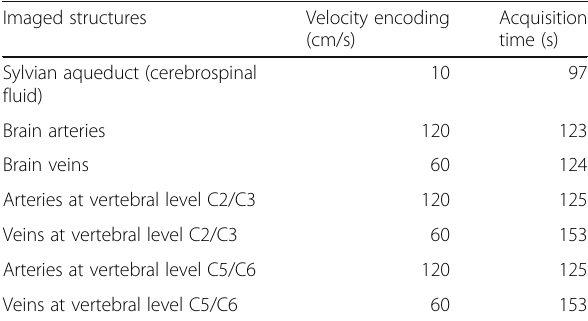
Table 2 Velocity encoding and acquisition time of the applied quantitative-flow two-dimensional phase-contrast